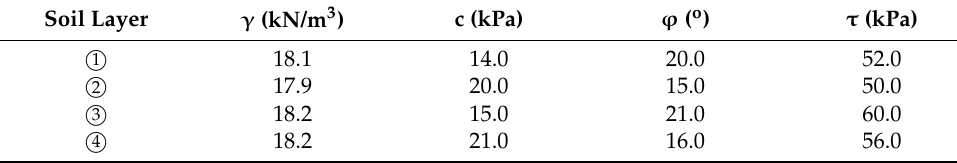
Table 2. The mechanical parameters of the